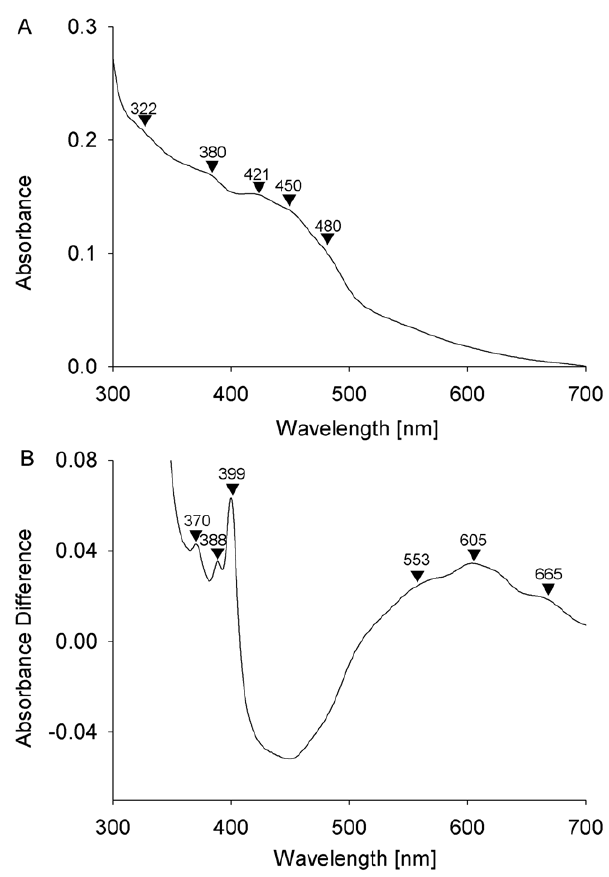
Figure 3. UV/vis spectra of oxidized (as-isolated) and reduced HoxFU. Panel A shows the spectrum of an as-isolated sample (4.8 m M). Prominent peaks and shoulders are indicated by arrows (see text for assignment). Panel B shows the difference spectrum of dithionite reduced (330 m M) minus as-isolated samples.